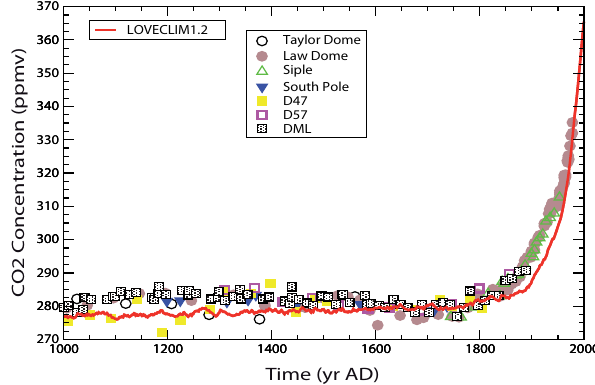
Fig. 16. Atmospheric CO 2 concentration in LOVECLIM1.2 (red Fig. 16 Atmospheric CO 2 concentration in LOVECLIM1.2 (red line) compared to measures line) compared to measures made in various ice cores: Taylor Dome made in various ice cores: Taylor Dome (Indermühle et al., 1999), Law Dome (Etheridge et (Indermhle et al., 1999), Law Dome (Etheridge et al., 1998), Siple al., 1998), Siple (Neftel et al., 1994), South Pole (Siegenthaler et al., 2005), D47 (Barnola (Neftel et al., 1994), South Pole (Siegenthaler et al., 2005), D47 (Barnola et al., 1995), D57 (Barnola et al., 1995), Drauning Maud et al., 1995), D57 (Barnola et al., 1995), Drauning Maud Land (DML, Siegenthaler et al., Land (DML, Siegenthaler et al., 2005).